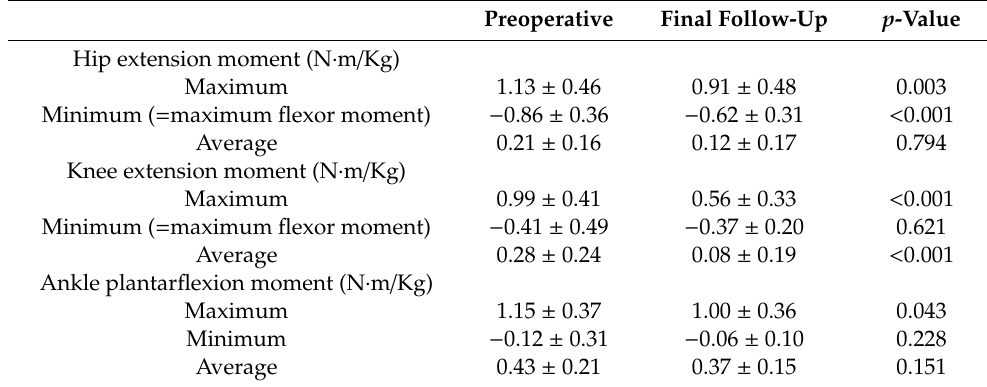
Table 6. Preoperative and final follow-up kinetic variables for the whole cohort.